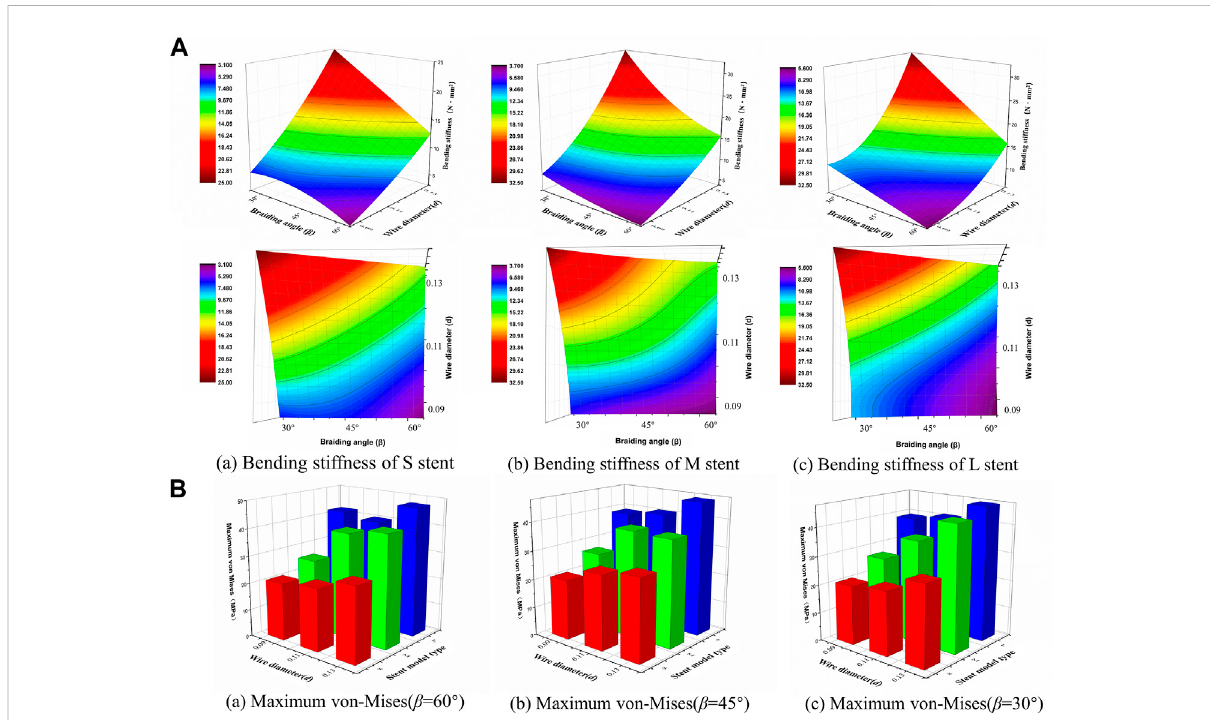
FIGURE 6 Response surface diagram of bending stiffness and comparison of the maximum von-Mises. (A) Comparison the bending stiffness of different stent model types in front view/top view: (a) Bending stiffness of S stent under different wire diameter ( d ) and braiding angle ( β ). (b) Bending stiffness of Mstent under differentwire diameter ( d )and braiding angle ( β ).(c) Bending stiffness of Lstent under different wire diameter ( d )and braiding angle ( β ). (B) Comparison of the maximum von-Mises of stent with 60 ° /45 ° /30 ° braiding angle